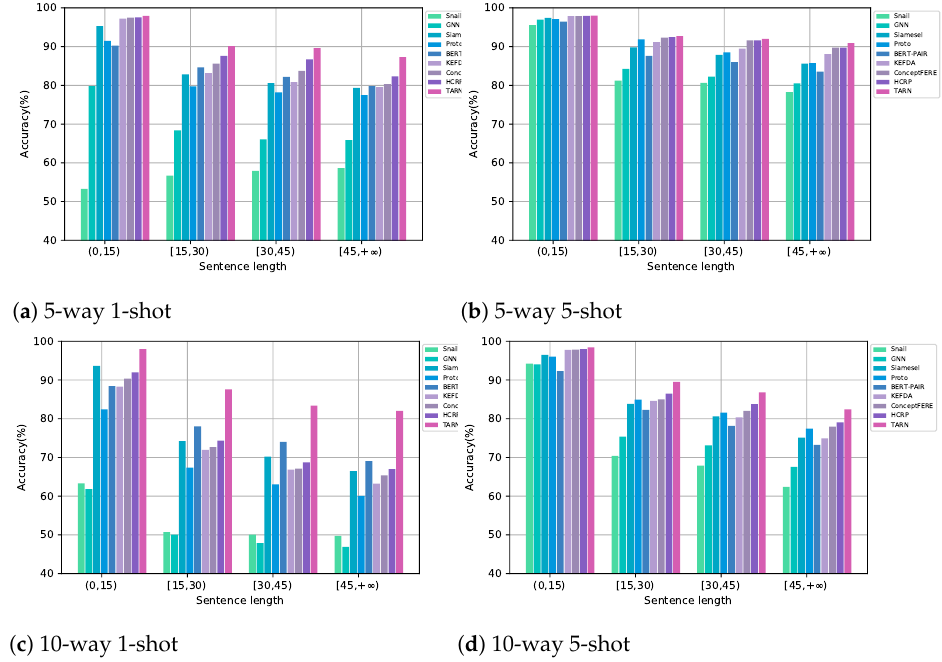
Figure 4. Effect on the performance of our proposed method and baselines affected by sentence length on four typical meta tasks: 5-way 1-shot, 5-way 5-shot, 10-way 1-shot and 10-way 5-shot.